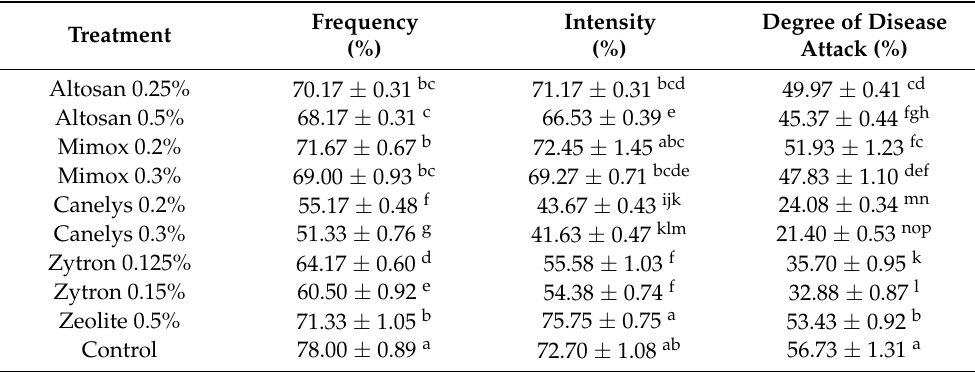
Frequency Intensity Degree of Disease (%) (%) Attack (%)